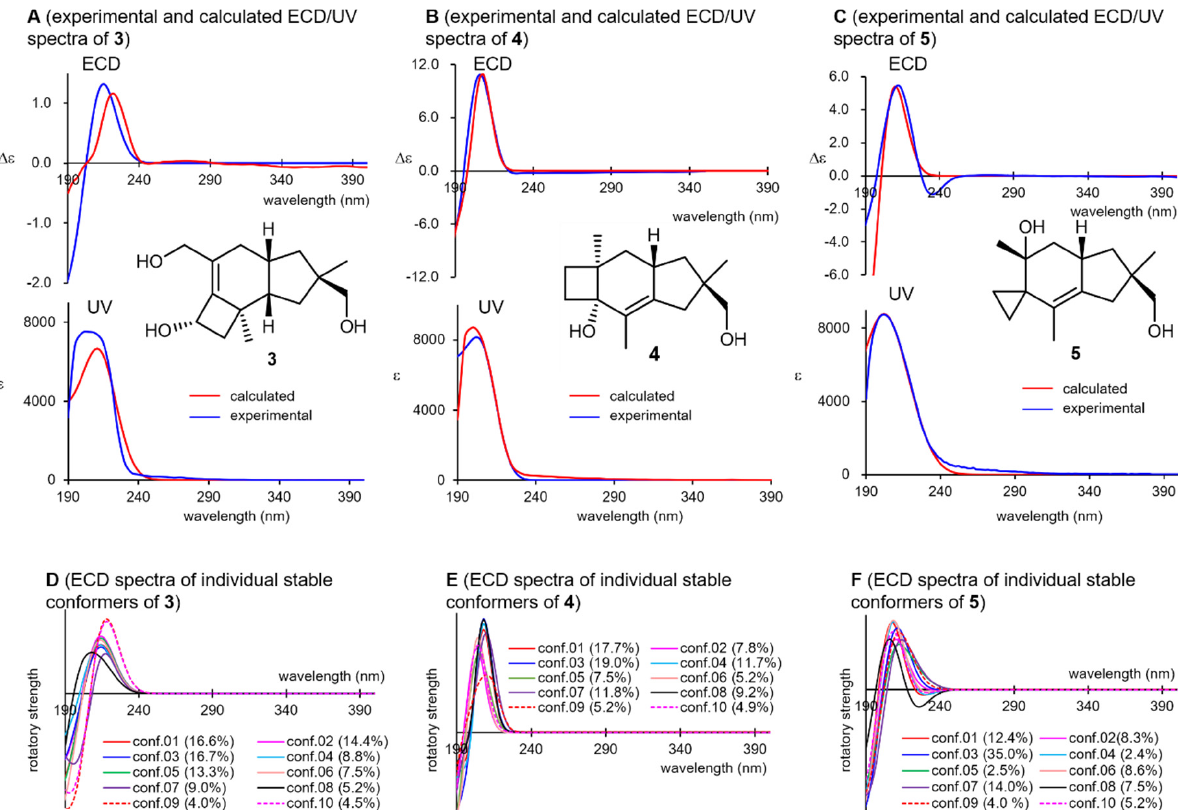
Figure 5. Experimental and calculated ultraviolet/electronic circular dichroism (ECD) spectrum of 3 – 5 (spectra A – C ) and their constituent ECD spectra of the individual stable conformers (spectra D – F ).